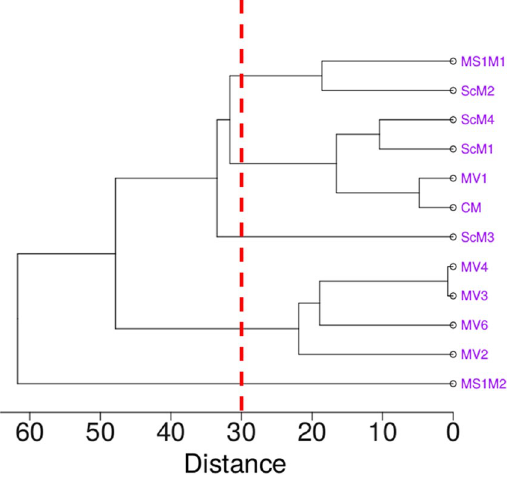
Figure 3. Dendogram obtained for the synthesized samples (MV1-6) and historical samples (ScM1-4, MS1M1- 2, and CM) in terms of the distribution of the different chromophores. The construction resorts to the average linkage method with Euclidean distances, using the main chromophores attributed on the basis of their relative integrated areas as variables.